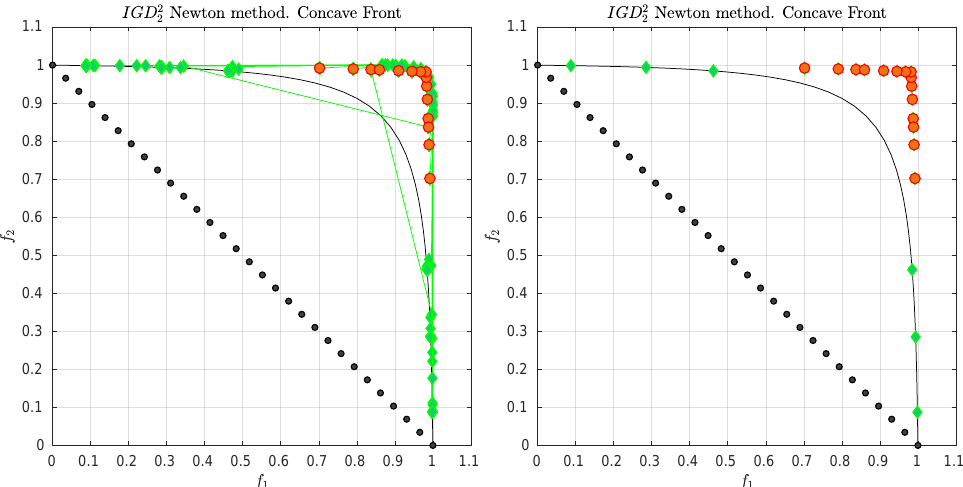
Figure 9. ( Left ) application of the IGD 2 -Newton method on BOP (50). ( Right ) the image of the final 2 archive (green) together with the images for which m l = 0. Table 3. Numerical results of IGD 2 -Newton method for BOP (50), see Figure 9. 2 Iter.